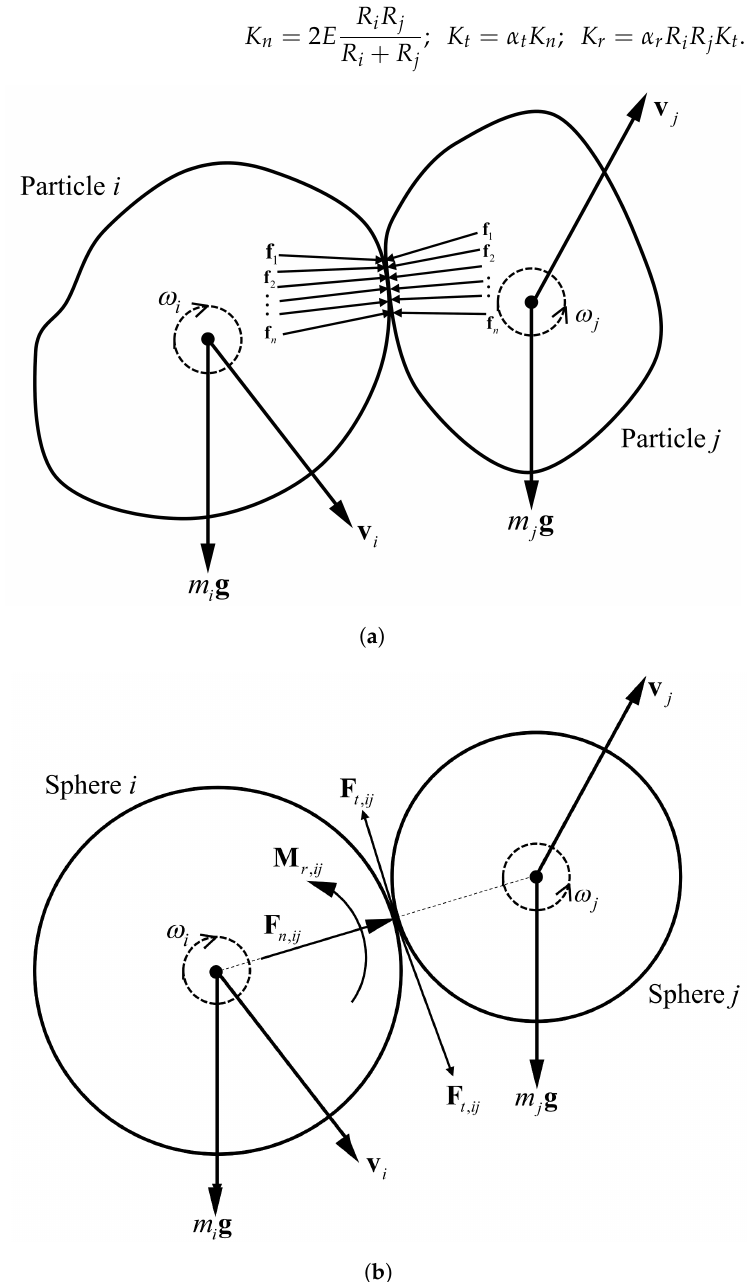
Figure 1. The interaction between ( a ) two real particles, and ( b ) two spheres in DEM ( m i is the mass of particle i , g is the gravitational acceleration, F t , ij is the tangential contact force between the particles, F n , ij is the normal contact force between the particles, M r , ij is the rolling moment between the particles, f n is the force interaction between the particles, v i is the linear velocity, and ω i is the angular